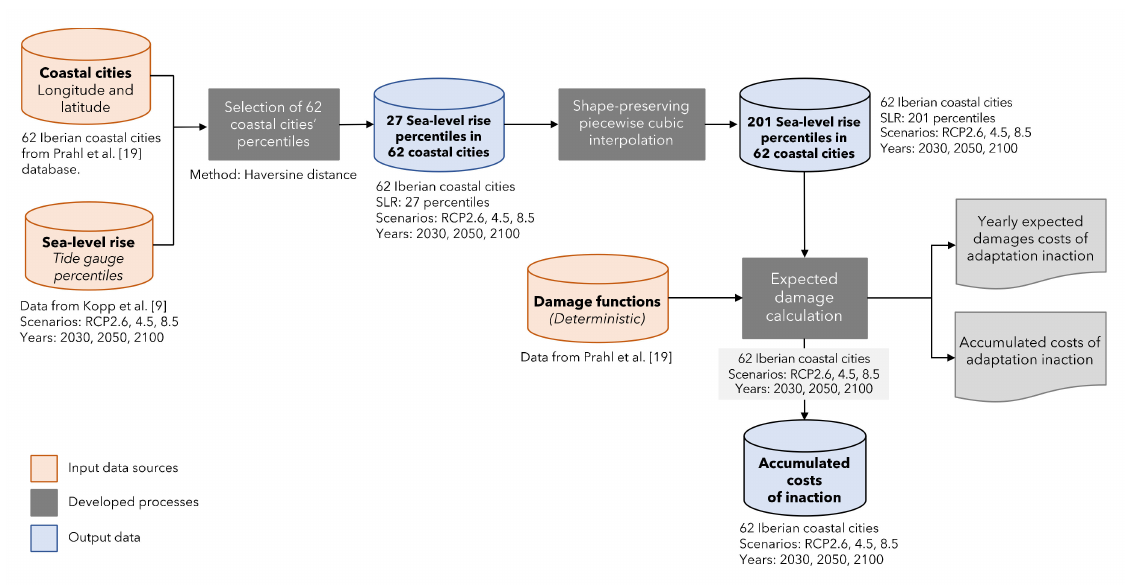
Figure 1. Summary of the methodology followed, including input data and output products.